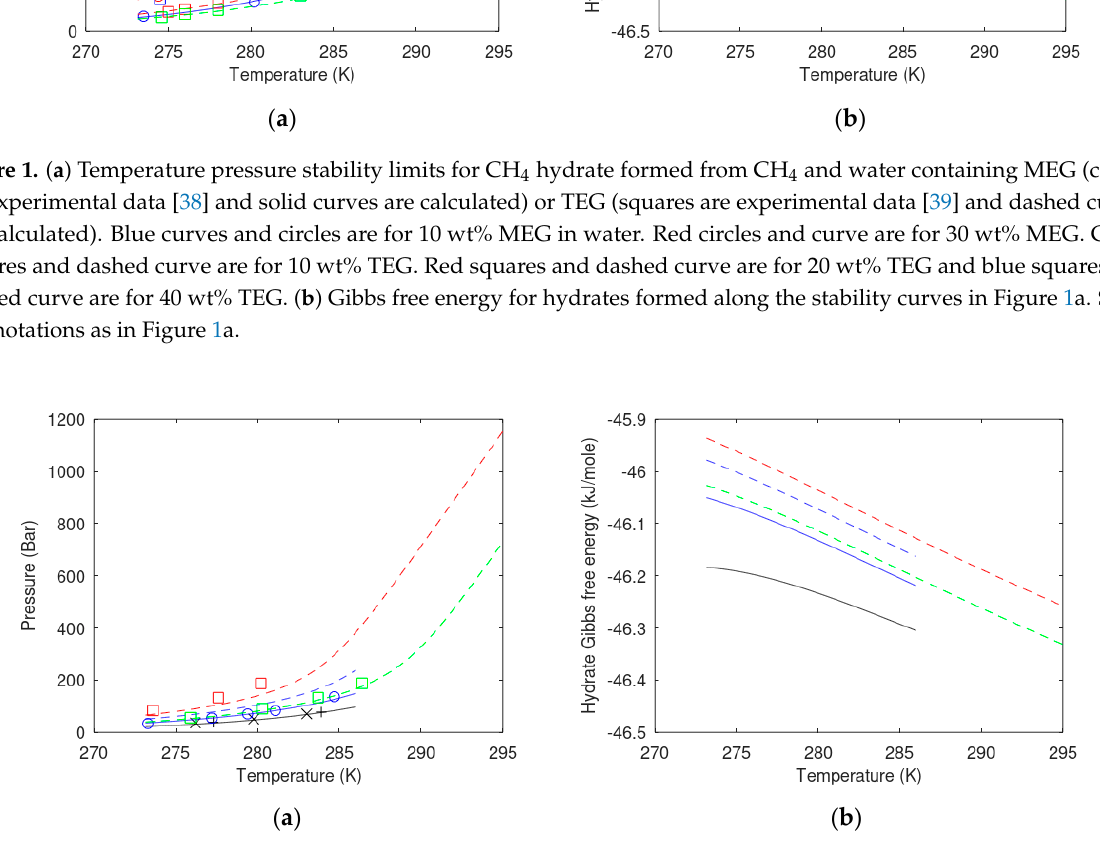
Figure 2. ( a ) Temperature pressure stability limits for CH 4 hydrate formed from CH4 and water containing ethanol (circles are experimental data [40] and solid curves are calculated) and methanol (squares are experimental data [41] and dashed curves are calculated). Blue circles and solid blue curves are for 15 wt% ethanol. Green squares and dashed curve are for 10 wt% methanol. Dashed blue is for 15 wt% methanol. Red squares and dashed are for 20 wt% methanol. Solid black curve is calculated data for pure water. Crosses are experimental data from Sabil et al. [42] and plusses are experimental data from Tumba et al. [43]. ( b ) Gibbs free energy for hydrates formed from CH 4 and water containing various concentrations of ethanol and methanol. Same notations as in Figure 2a.